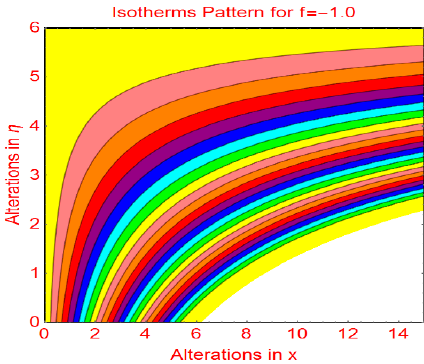
Figure 11. Isotherms profile for ( a ) f 1 = 0.0 ( b ) f 1 = 1.0.